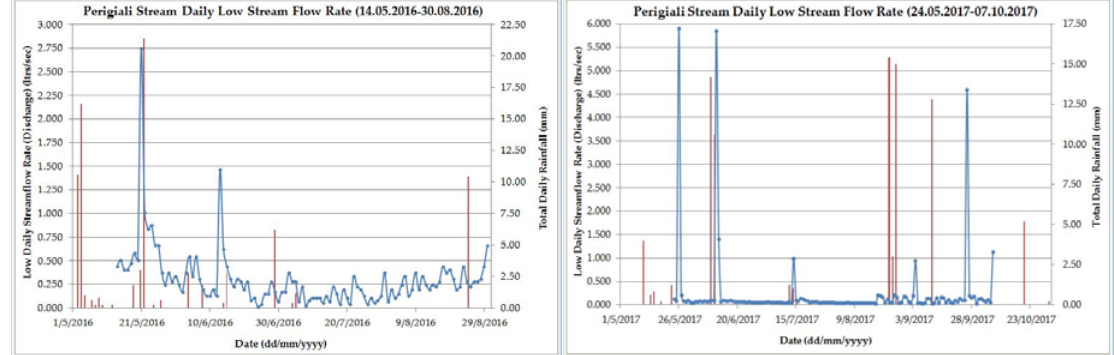
Figure 3. Parshall flumes and V ‐ Notched weir gauging station, Perigiali Stream area, Kavala city, Greece [Daily low stream flow rate (continuous horizontal fluctuating blue line vs. Total daily rainfall (continuous vertical red bars), (14 May 2016–30 August 2016, on the left ), (24 May 2017–7 October 2017, on the right